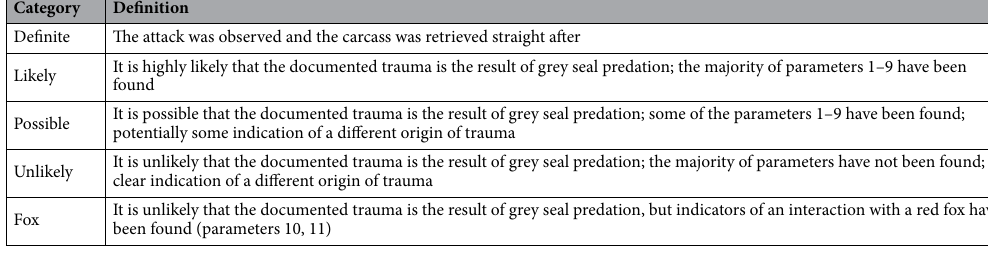
Table 1. Categories and their respective description used for rating the likelihood of grey seal predation and fox